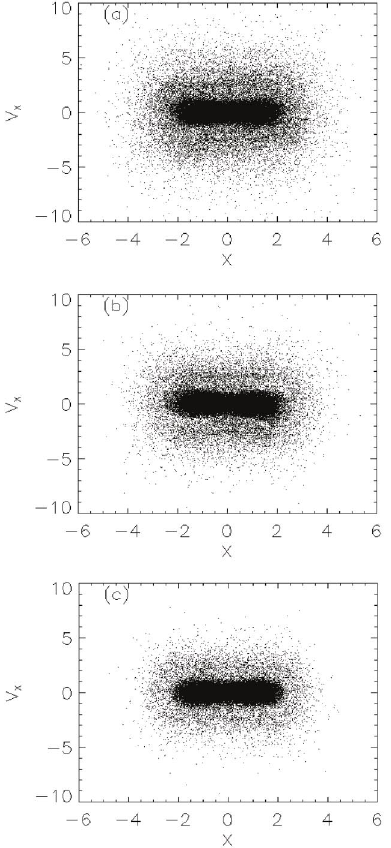
FIG. 7. Oscillation of the rms width of the beam with nonlinear focusing at the last minimum rms width when S (cid:10) 300 for (cid:4) (cid:1) (cid:4) a (cid:5) 1.5, (b) 1.35, (c) 1.2.